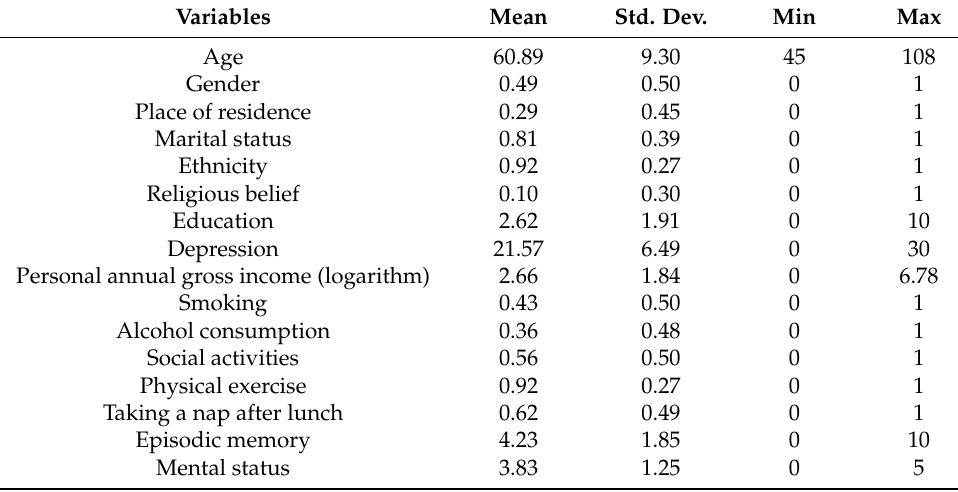
Table 2. Demographic characteristics of samples in this study. Variables Std.